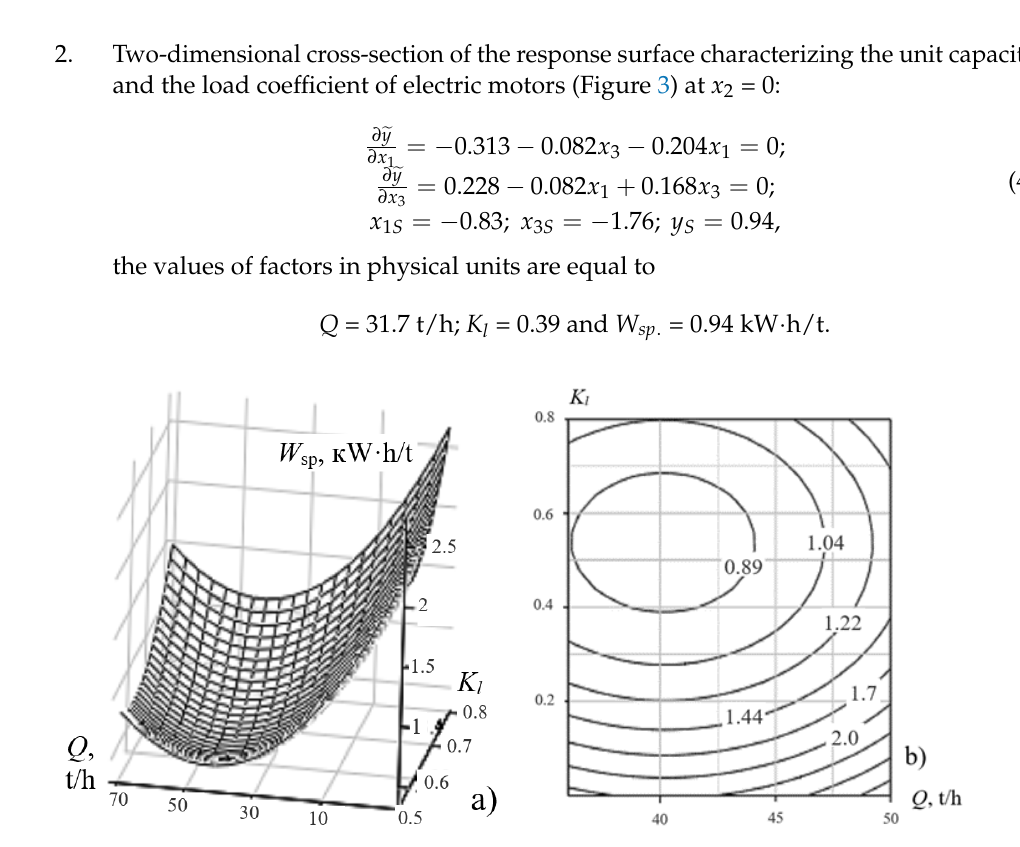
Figure 3. Response surface of the target function ( a ) and its two-dimensional cross-sections ( b ) for ZAV-40 at х 2 = 0.